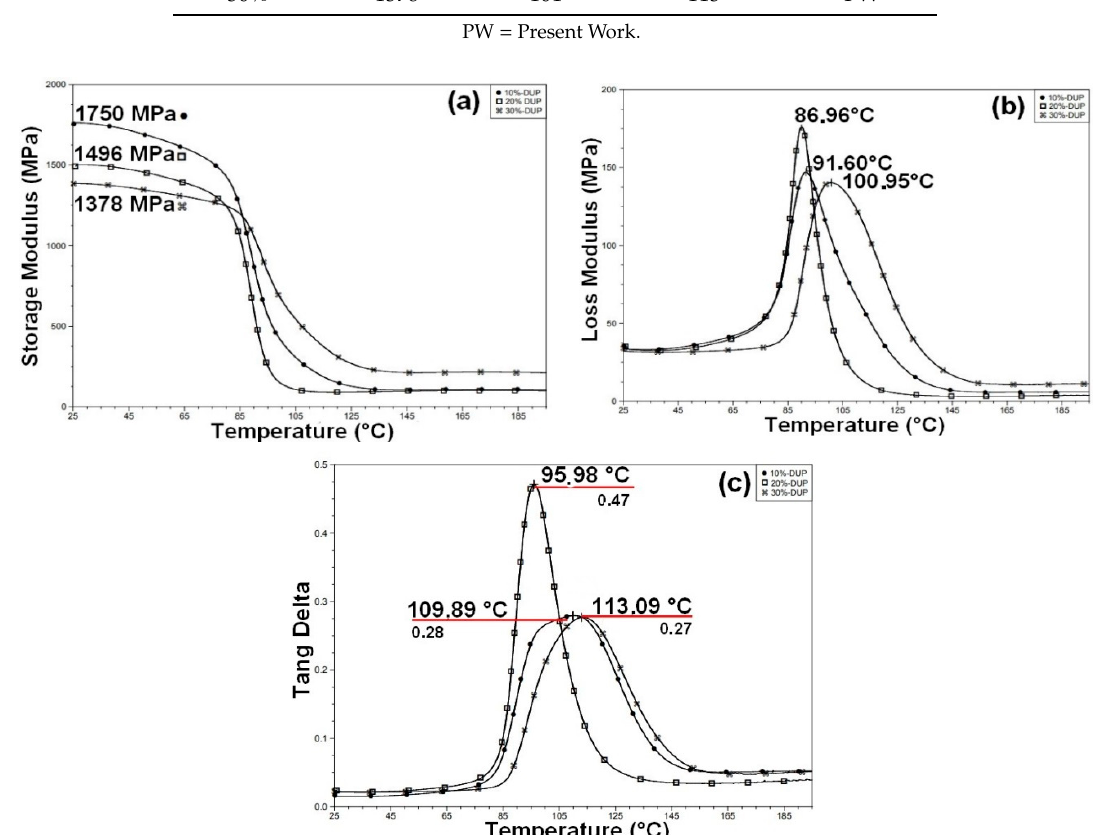
Figure 13. Dynamic mechanical analysis (DMA): ( a ) storage modulus; ( b ) loss modulus and ( c ) tangent delta for the caranan fiber composites.